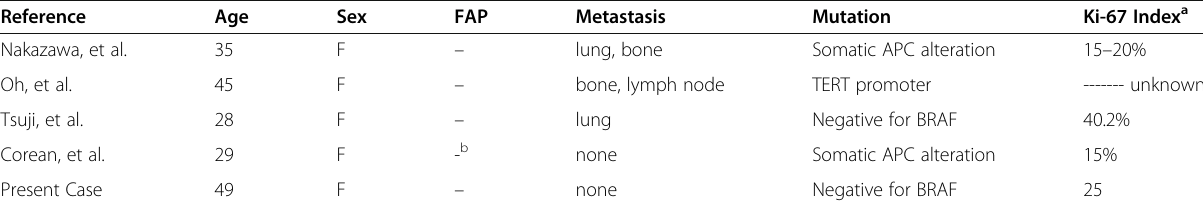
Table 1 Reported cases of cribriform-morular variant of papillary thyroid carcinoma with poorly Differentiated